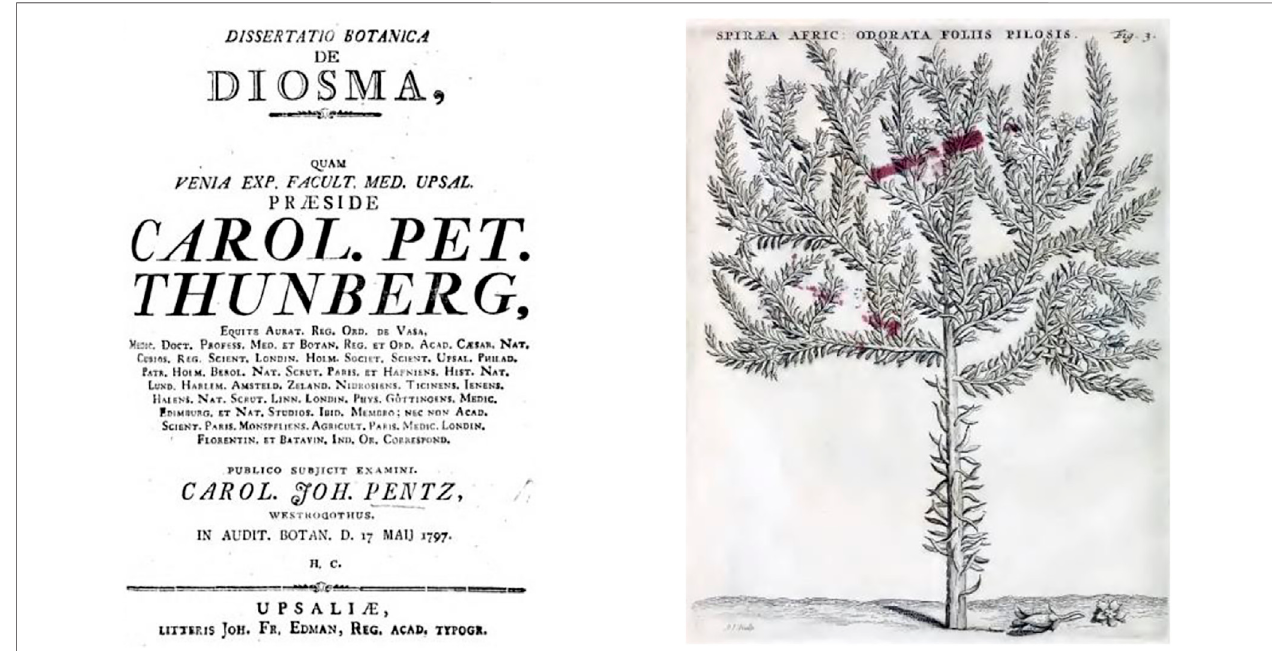
FIGURE 1 | Title page of Thunberg ’ s Dissertatio Botanica de Diosma (1799), Spiraea Africana odorata in Commelin (1706).